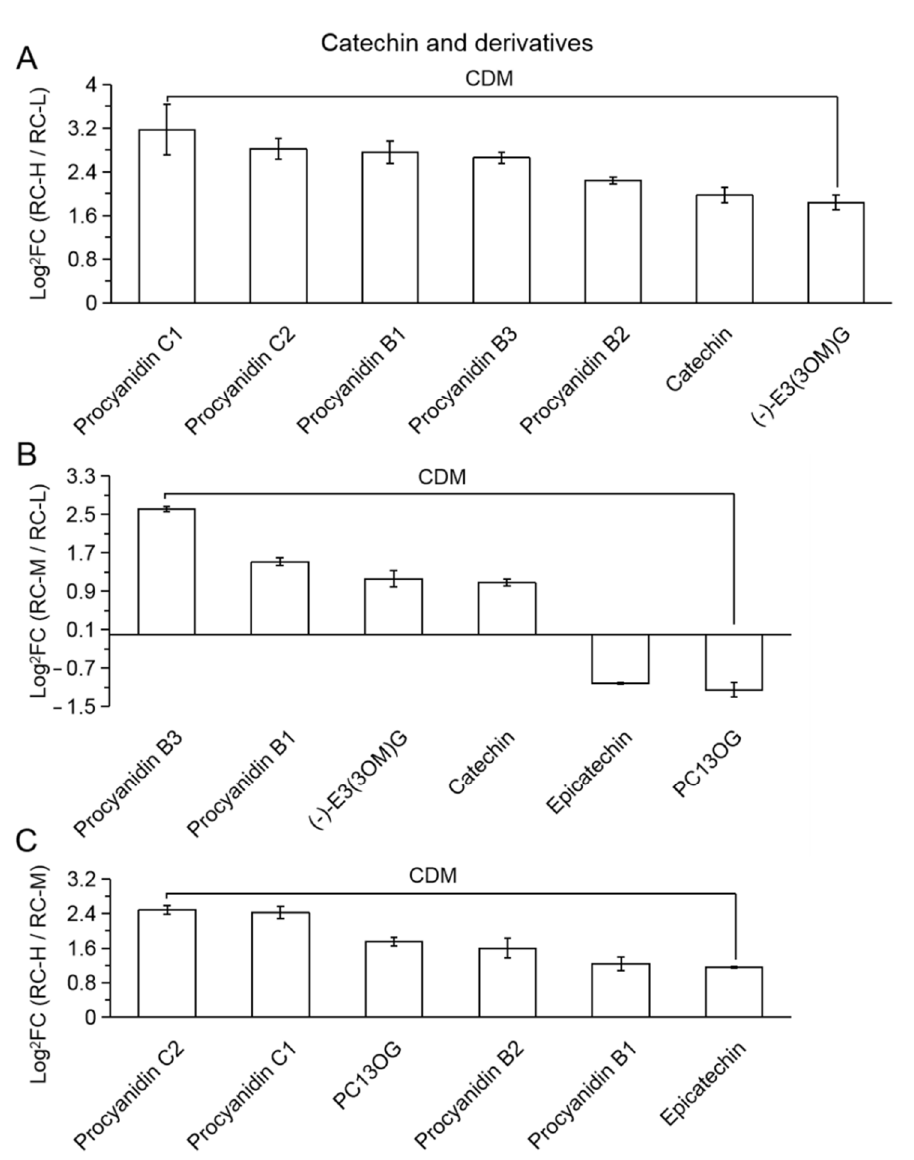
Figure 9. Comparison of differential metabolites of catechin and derivatives between RC-L, RC-M and RC-H. These were 7 CDMs for RC-H vs. RC-L ( A ), 6 CDMs for RC-M vs. RC-L ( B ), and 6 CDMs for RC-H vs. RC-M ( C ), respectively. Upregulation denotes that the content of a metabolite in RC increased with elevation between two altitudes, and the opposite for downregulation. The Y-axis is shown as Log 2 FC values for the convenience of visual presentation (Note: The up-amplitude in the text refers to the FC value). The X-axis denotes metabolite names.